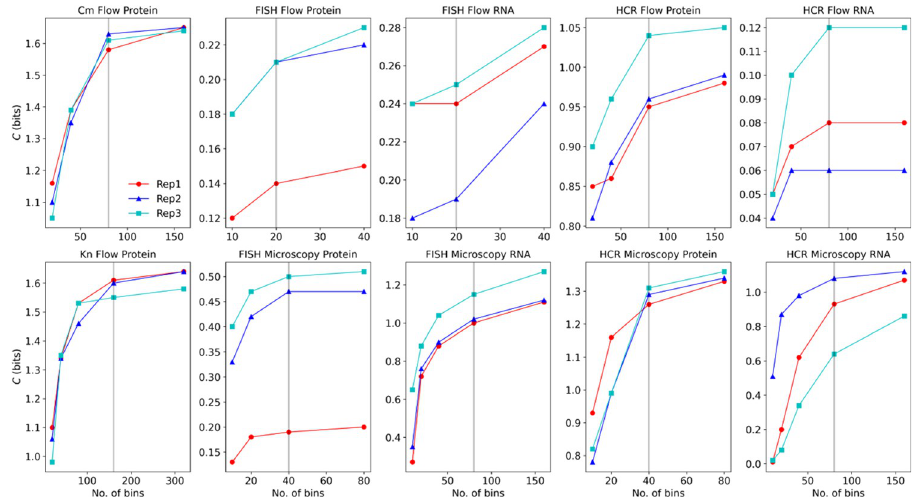
Fig 5. Dependence of channel capacity on the number of bins used to construct the empirical RNA or protein distributions for each of the methods. The vertical gray line shows the number of bins used to compute the channel capacity reported in the